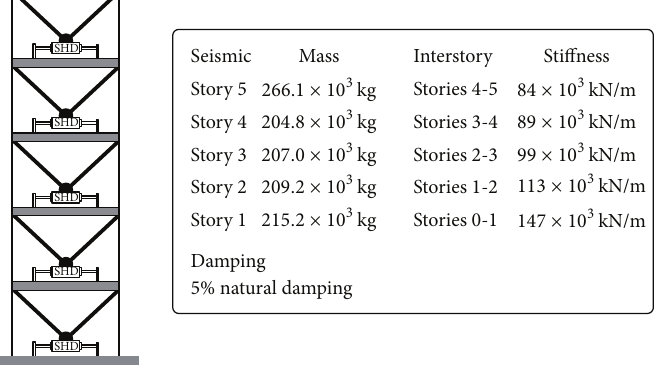
Figure 1: A five-story structure model similar to Kajima Shizuoka Building [8, 9].